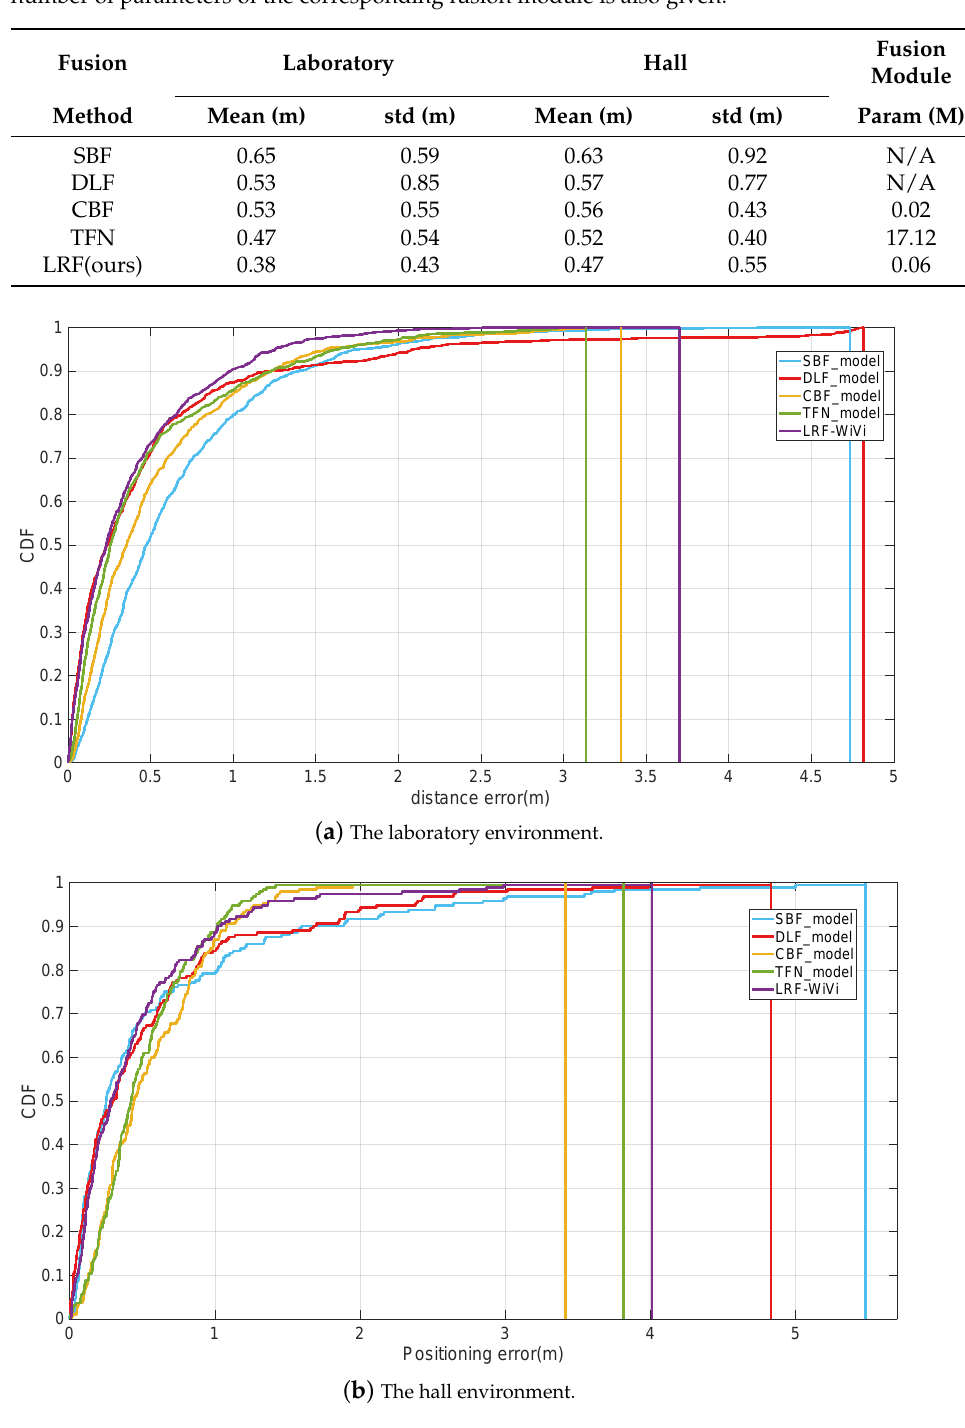
Figure 13. Comparison of positioning errors distribution of different fusion